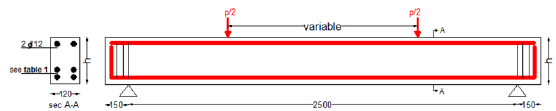
Figure 1: Details of a typical specimen